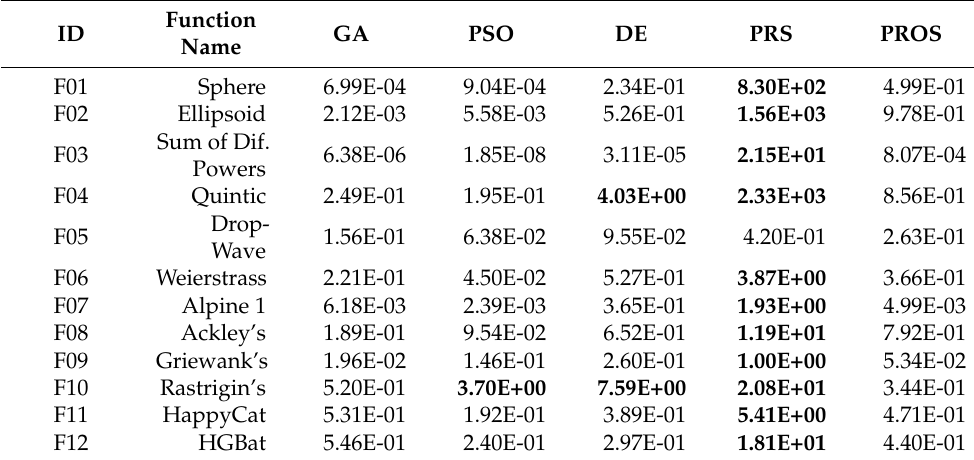
Table 5. Best results * for all 5 optimizers and all 12 objective functions, for 5 dimensions ( D = 5, averages of 10 runs). The target (optimum) value is zero in all cases